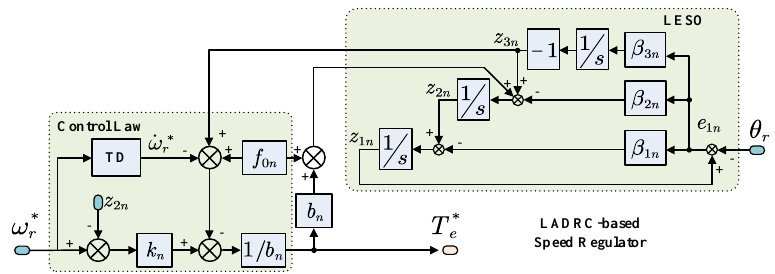
Figure 2. Block diagram of the LADRC-based speed regulator.